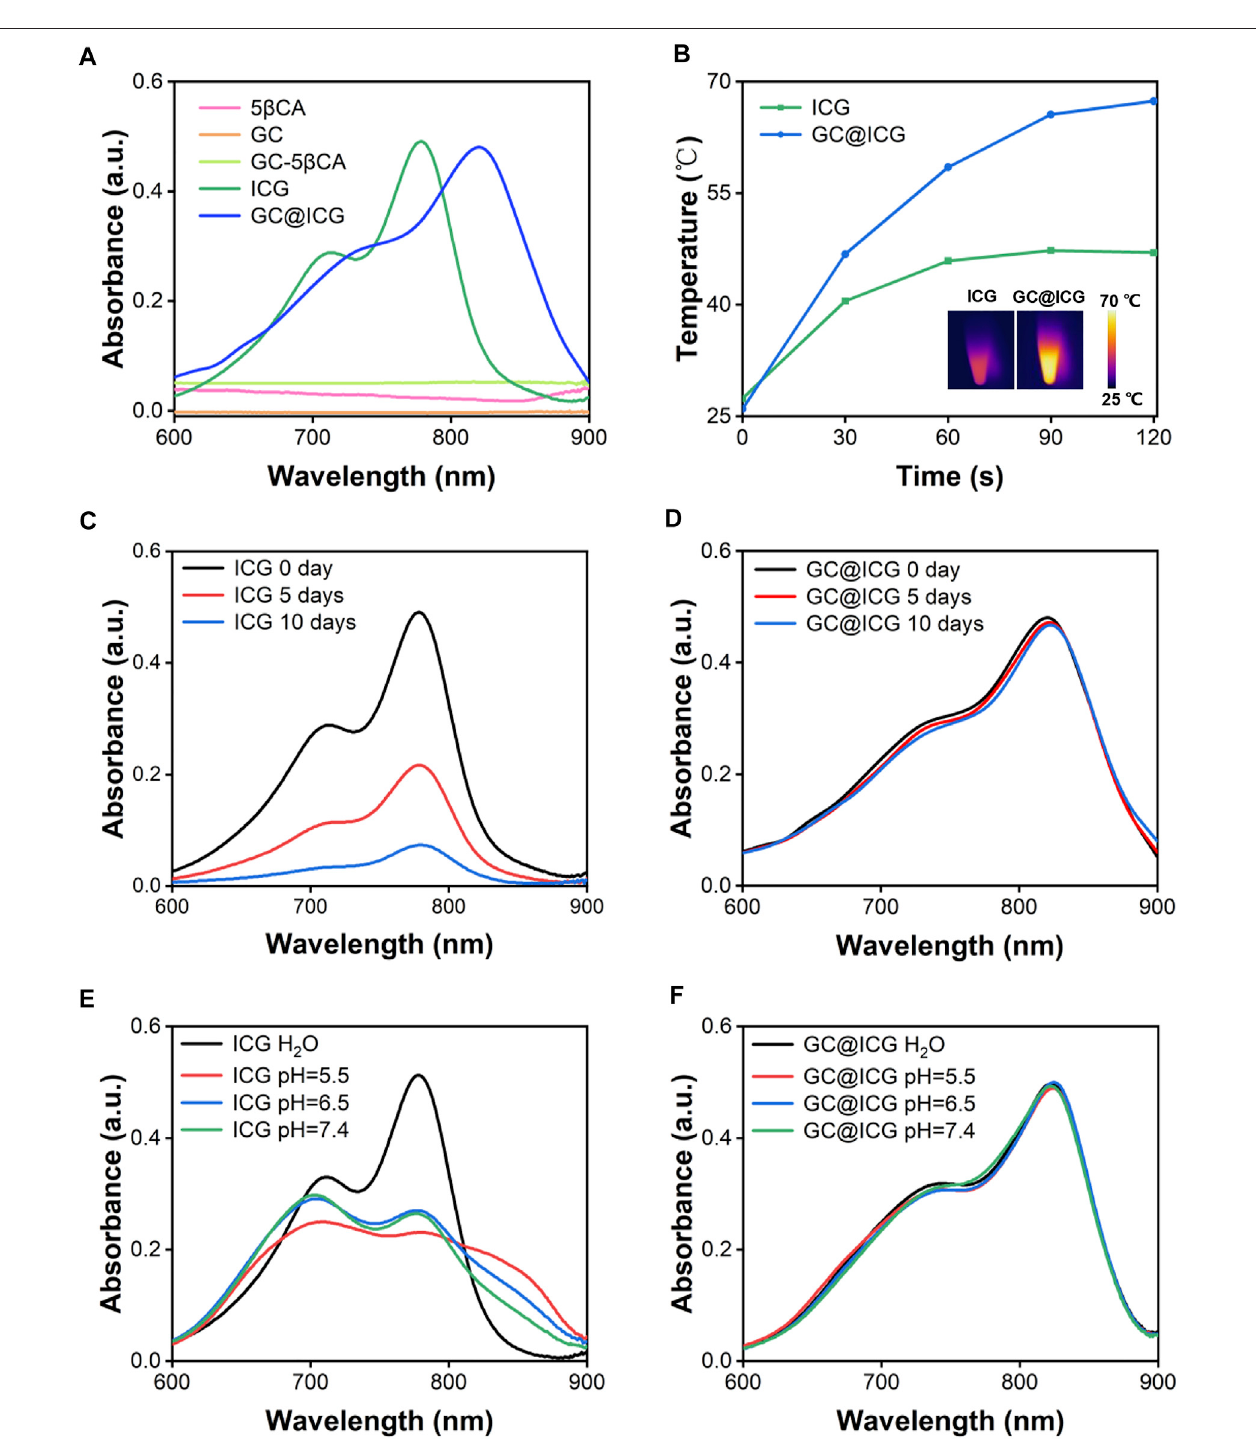
FIGURE2| AbsorptionspectraofICGandGC@ICGatdifferenttimesandaqueoussolutions. (A) UV-vis-NIRabsorptionspectraofICG,GC@ICG,GC,5 β CA,and GC-5 β CA. (B) TemperaturecurvesofICGandGC@ICGsolutionunder808 nmlaserirradiationwithapowerdensityof0.8 W/cm 2 for120 s.Inset:near-infraredthermal imagesof ICG and GC@ICG after laser irradiation for 120 s. Absorption spectra of ICG (C) and GC@ICG (D) at different times (0, 5, and 10 days). Absorption spectra of ICG (E) and GC@ICG (F) in different aqueous solutions (pH 5.5, 6.5, 7.4 and H 2 O).